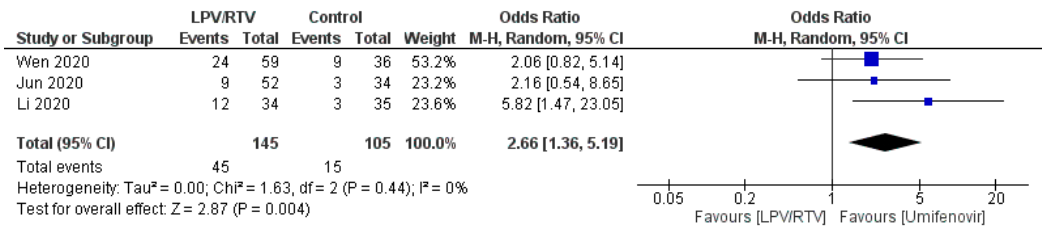
Figure 13. Rate of adverse events of treatment (LPV/RTV vs. umifenovir). CI, confidence interval; df, degrees of freedom; LPV/RTV, lopinavir/ritonavir.